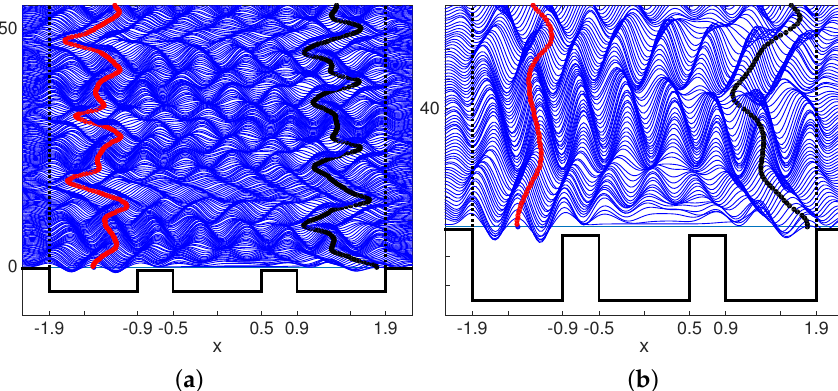
Figure 12. The shaking intensity is less intense and equal to Γ = 4.6. On the other hand the barrier heights have been lowered so that the fluid depth above them is equal to 0.06 cm. More wave transmission is being allowed. ( a ) On the left, we observe two droplets oscillating within their respective cavities. The mid-cavity has the same depth as the side ones and is equal to 0.5 cm. The vertical axis indicates that the simulation goes a bit beyond time t = 250 T F . ( b ) On the right graph we observe a detail of the wave-field pattern. The mid-cavity is allowing for some communication between oscillators due to more wave transmission over both barriers.